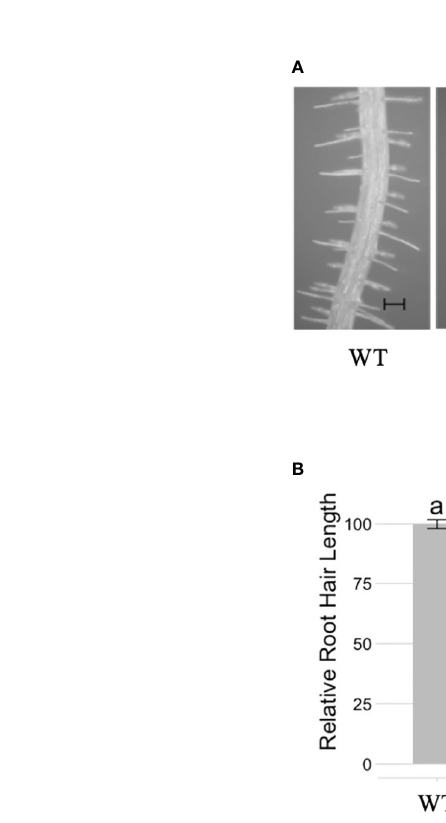
FIGURE 8 ccdc93-1 suppresses the vti13 short root hair phenotype. (A) Representative root hair images of wild type, vti13, ccdc93 and vti13 ccdc93 seedlings after 5 days of growth on 1X MS media. the bars are equal to 100 mm. (B) Quanti fi cation of fi ve-day-old seedling root hair phenotypes grown on 1X MS media. Data presented are the pooled results of three independent experiments in which 15 root hairs per seedling were measured and 10 total seedlings/genotype were assayed. Letters above the bar represent statistically signi fi cant groupings at the p<0.001 level are based upon the results of analysis of variance (ANOVA) and Tukey ’ s honestly signi fi cant difference tests. Scale bars are equal to 100